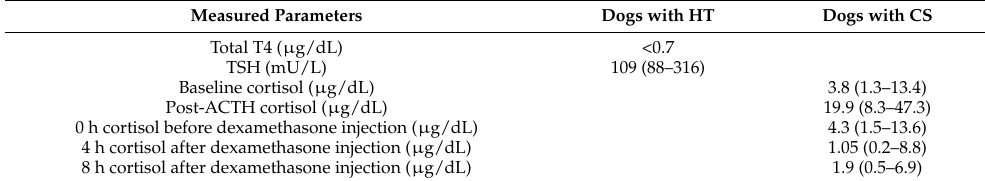
Table 2. Parameters (median and range) used to diagnose hypothyroidism (HT) or Cushing’s syndrome